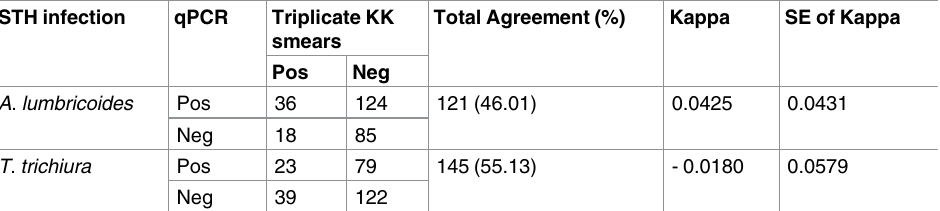
Table 6. Parasiteprevalenceagreementstatistics between triplicate thick smearKK and qPCR for the diagnosis of STH infections in stool samples from 263 schoolchildren in Laguna province, Philippines.